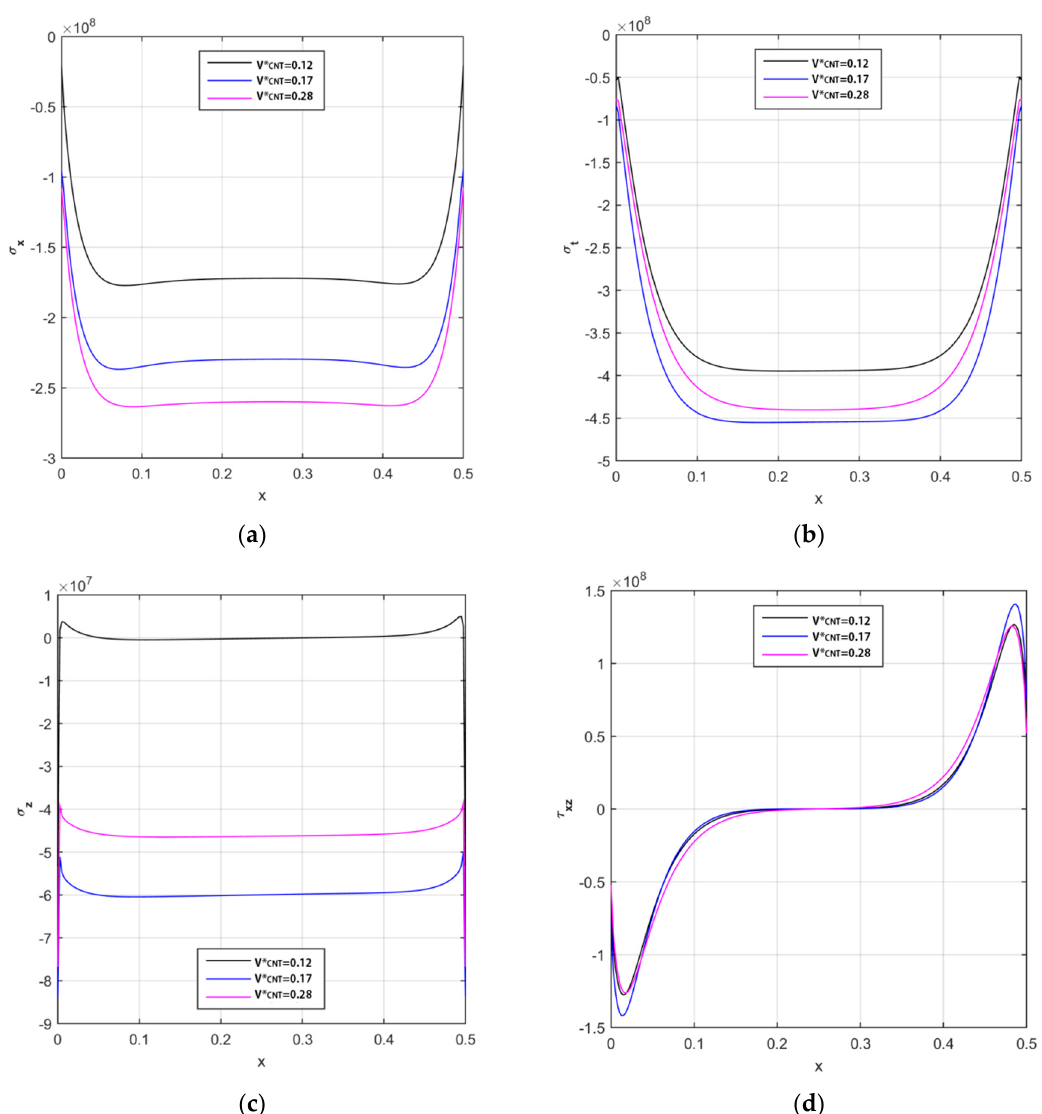
Figure 9. The longitudinal distribution of the axial ( a ), circumferential ( b ), radial ( c ), and shear ( d ) stress components [Pa] of CNTRC cylinder for different volume fractions.